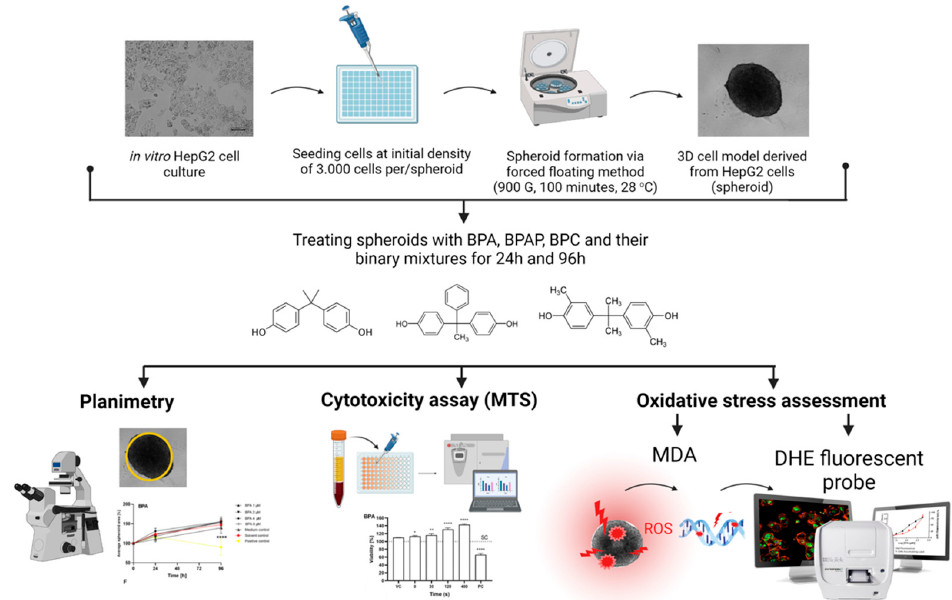
Figure 1. Schematic overview of the research process. Spheroids were formed from HepG2 single-cell suspension with an initial density of 3000 cells/spheroid using the forced floating method. After three days of culturing, spheroids were exposed to BPA, BPAP, BPC and their binary mixtures for 24 and 96 h. Various end-points were then measured, including planimetry, cell viability, and oxidative stress induction. The fi gure was made in BioRender program.